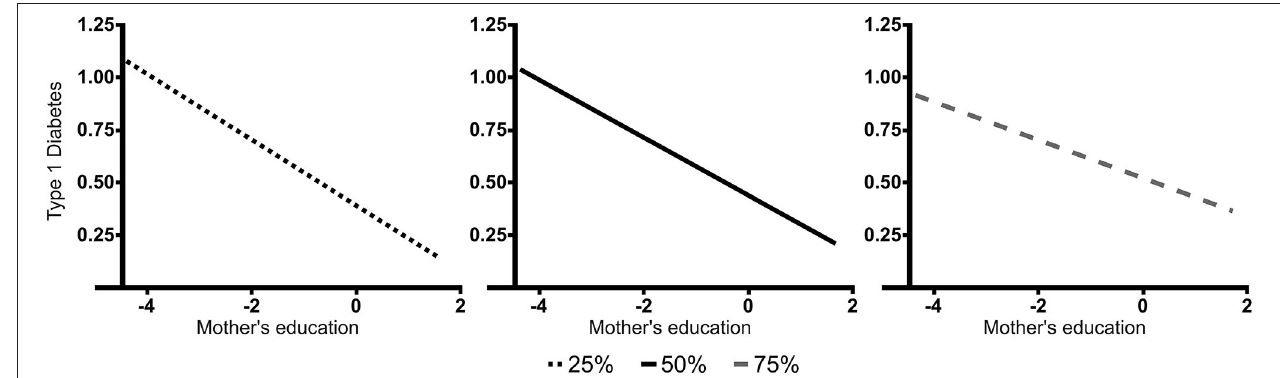
FIGURE 2 | The relationship between mothers’ education level and children’s T1D for different levels of carers’ attachment anxiety. The figure shows significant slopes for the three levels of carers’ attachment anxiety. The lower the mother’s education, the higher the association with T1D for all levels of carers’ attachment anxiety.